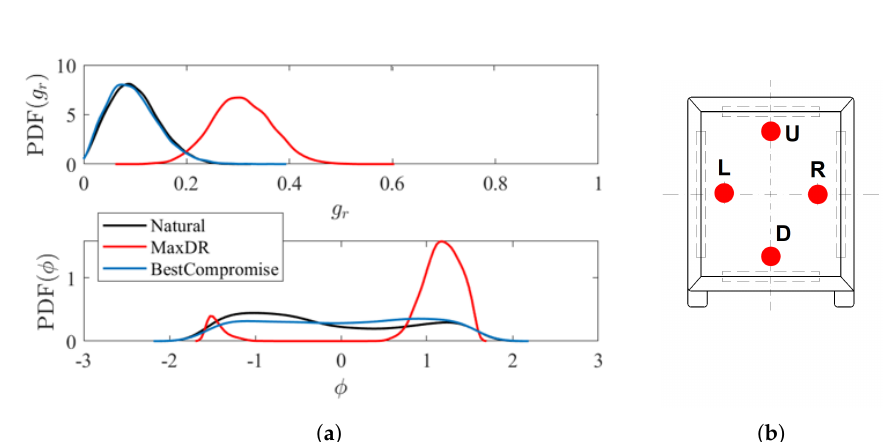
Figure 19. ( a ) Probability density function of the modulus and phase of the pressure gradient across the model’s rear base. ( b ) Location of the static pressure taps used to calculate the rear base pressure